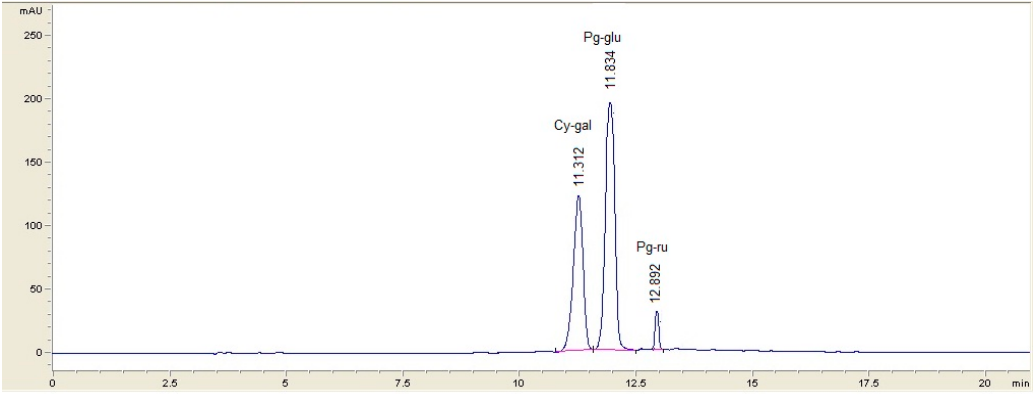
Figure 1. HPLC chromatogram (506 nm) of Cornelian cherry fruit juice .